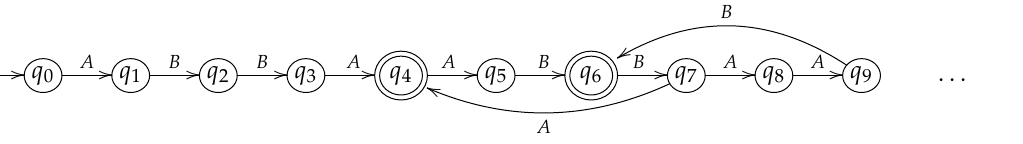
Figure 8. Example of an automaton accepting the terms of the sequence g ( n , k ) . q 0 = a 1,1 , q 1 = a 1, n + 1 , q 2 = a k , n + 1 , and so